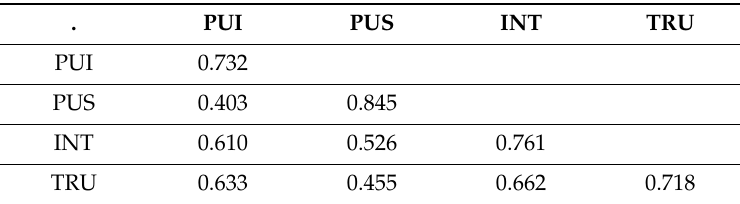
Table 4. Correlation coe ffi cient matrix and square roots of the average variance extracted (AVE) (shown as diagonal